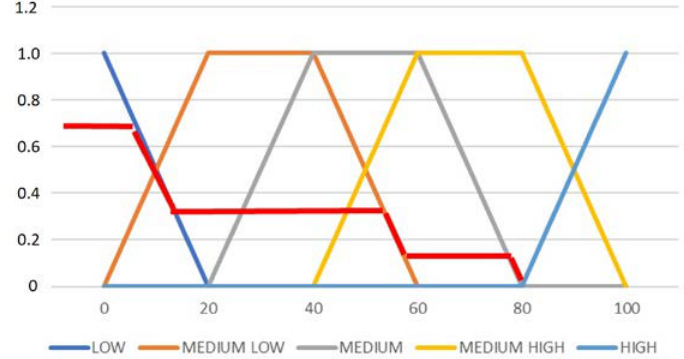
Figure 15. Aggregation of rules for machining technology 2. 15